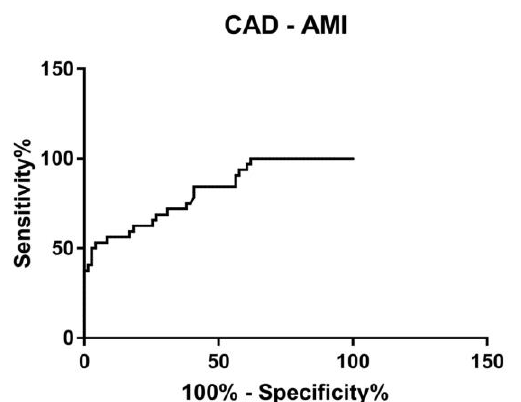
Figure 5. Receiver operator characteristic (ROC) analysis by combining Long and Short RECK expression levels. Area under the ROC curve (AUC) = 0.81, 95% confidence interval 0.73 to 0.90, p < 0.001.